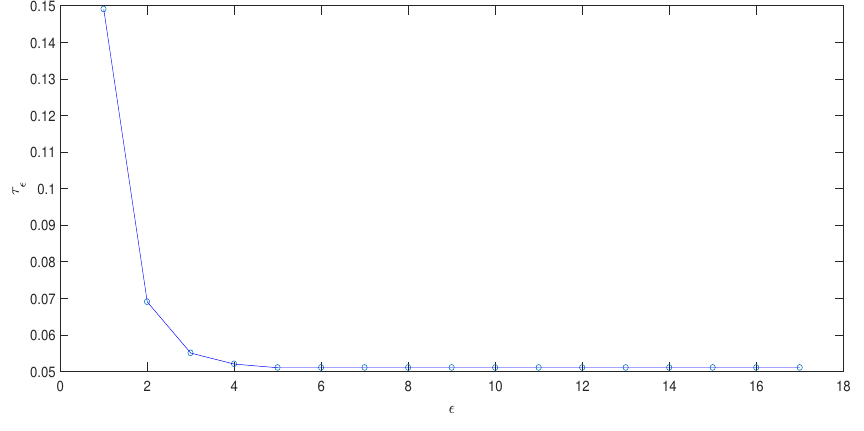
Figure 5. The orbit of τ σ vs. σ